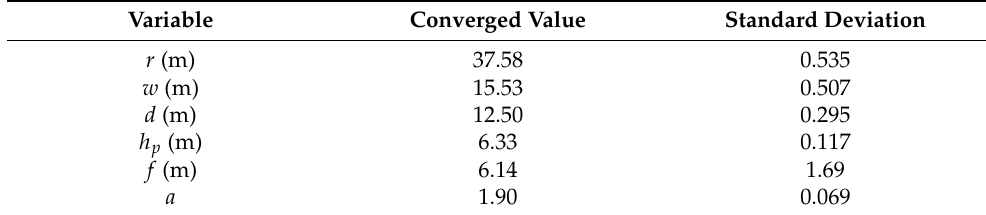
Table 20. Standard deviation for the 100th generation.